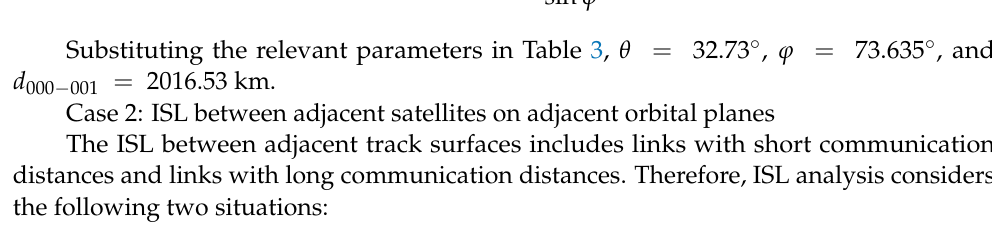
Figure 6. ISL between two satellites on the same orbit.